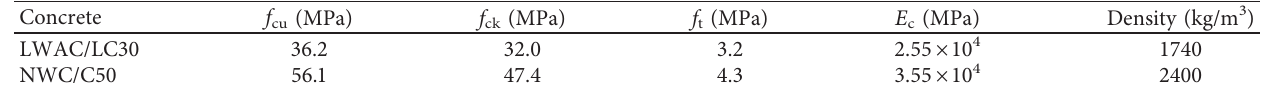
Table 3: Mechanical parameters of the concrete from the experiment [19].